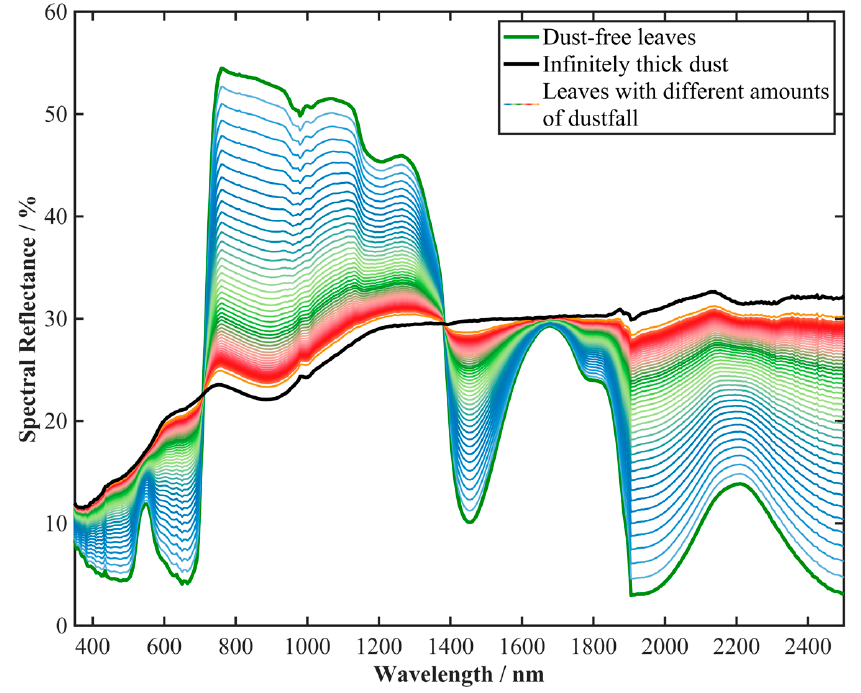
Figure 5. The Hapke two-layer medium model simulates the spectral curves of leaves with different amounts of dustfall, the results were calculated using Equation (6).